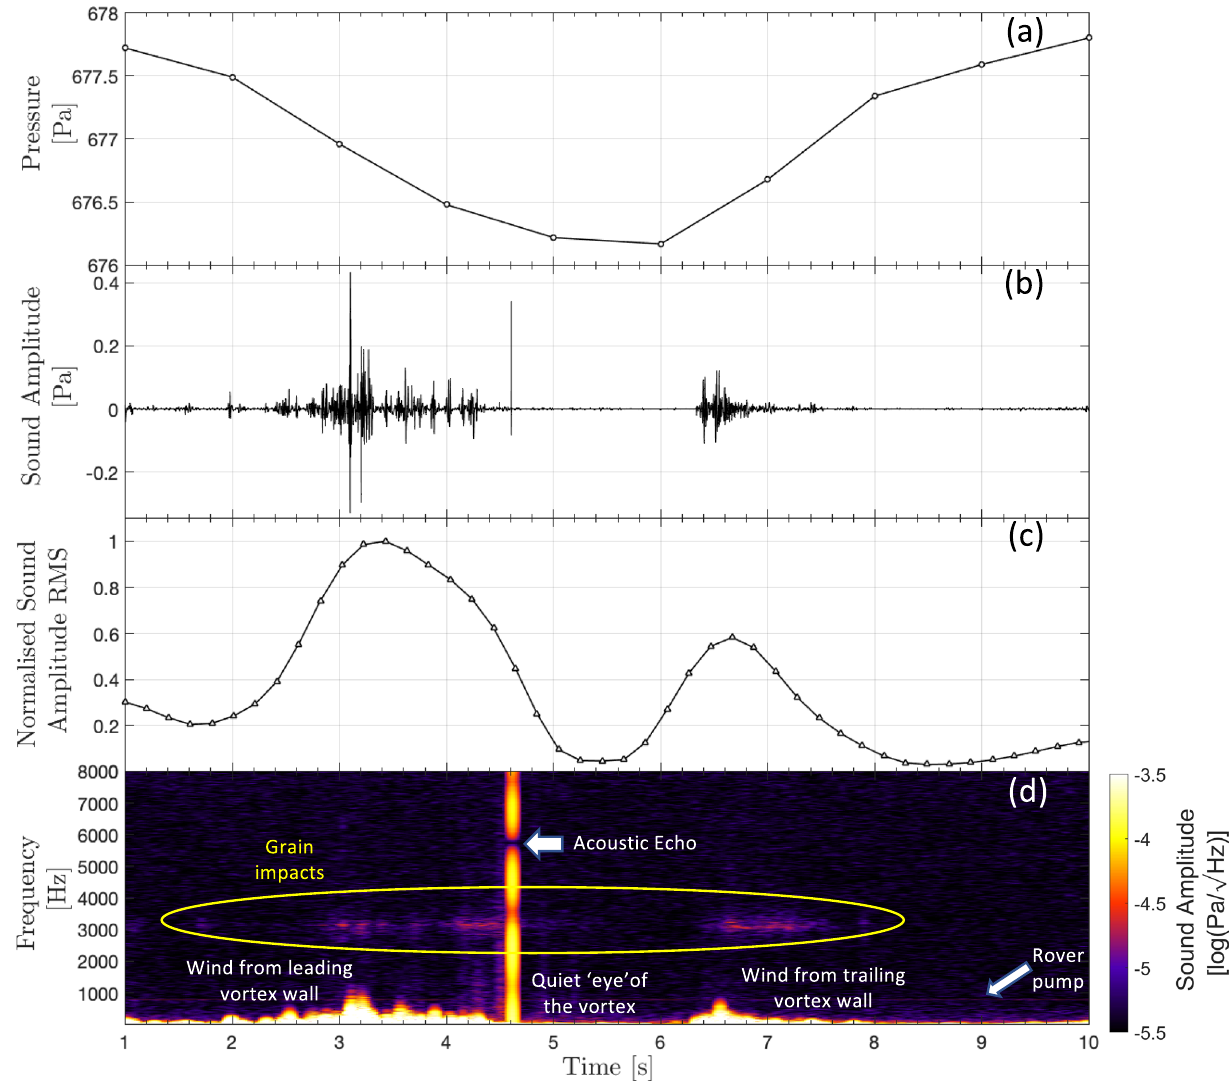
Fig. 1 | Acoustic data during a dusty vortex encounter. a The pressure data duringthedustdevilencounterat11.02LTSTonSeptember27,2021(Perseverance sol215), b theSuperCammicrophonesound amplitudeasafunctionof time, c the normalised Root-Mean-Square (RMS) of the microphone signal in the 20 – 60Hz bandwidth (the region containing the atmospheric signal 37,38 ) calculated in 2-s